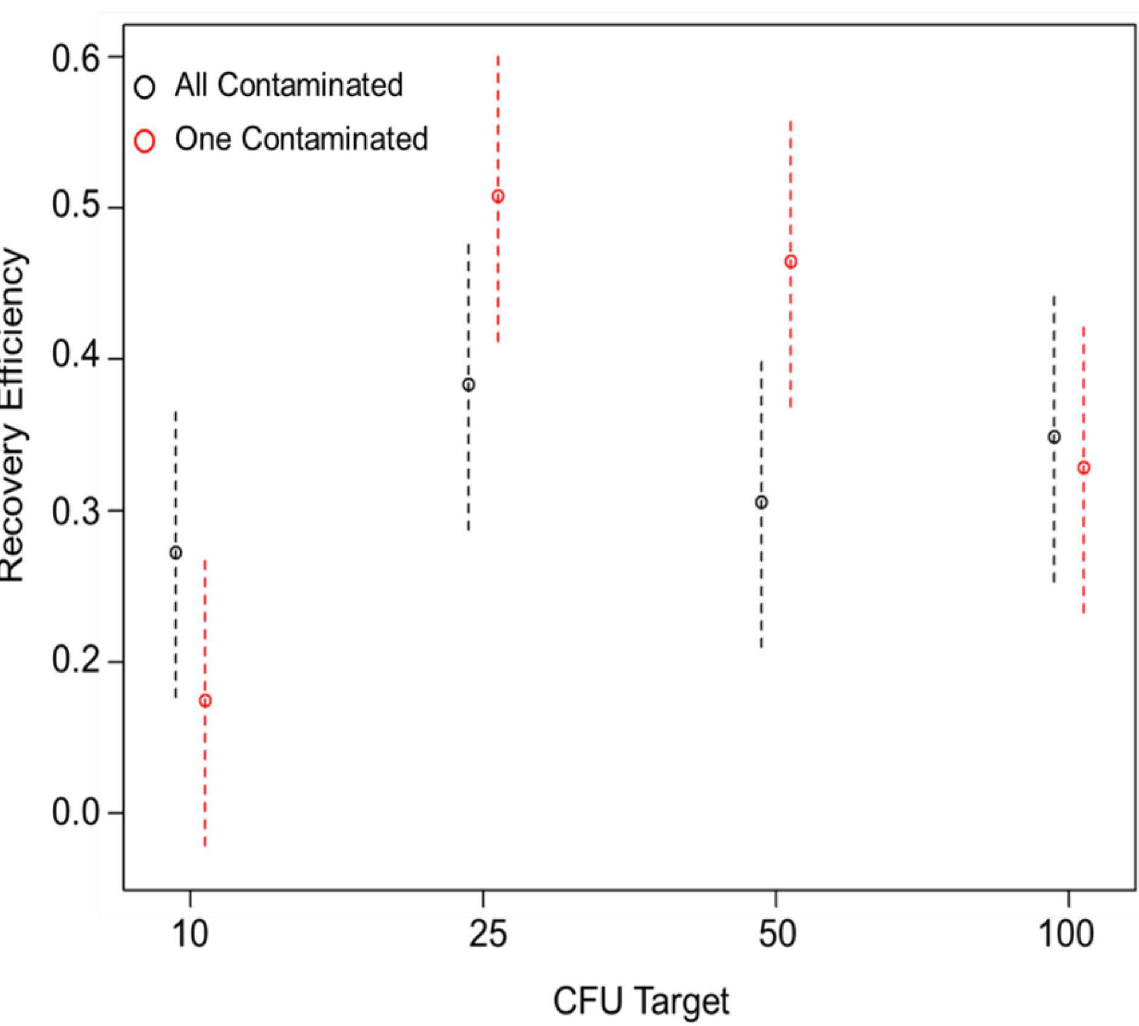
Fig 6. The interaction of two experimental factors, CFU target and number of contaminated locations, significantly affect recovery efficiency (p = 0.0271). The means are plotted as open circles and the error bars are representative of two standard